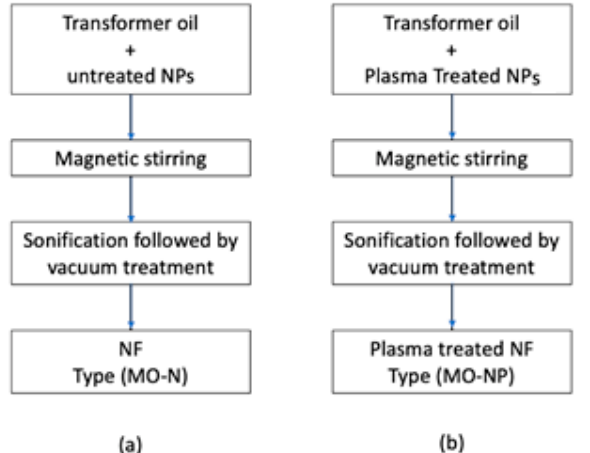
Figure 4. Flow chart for preparation of nanofluids with ( a ) fumed silica NPs ( b ) with plasma-treated fumed silica NPs.